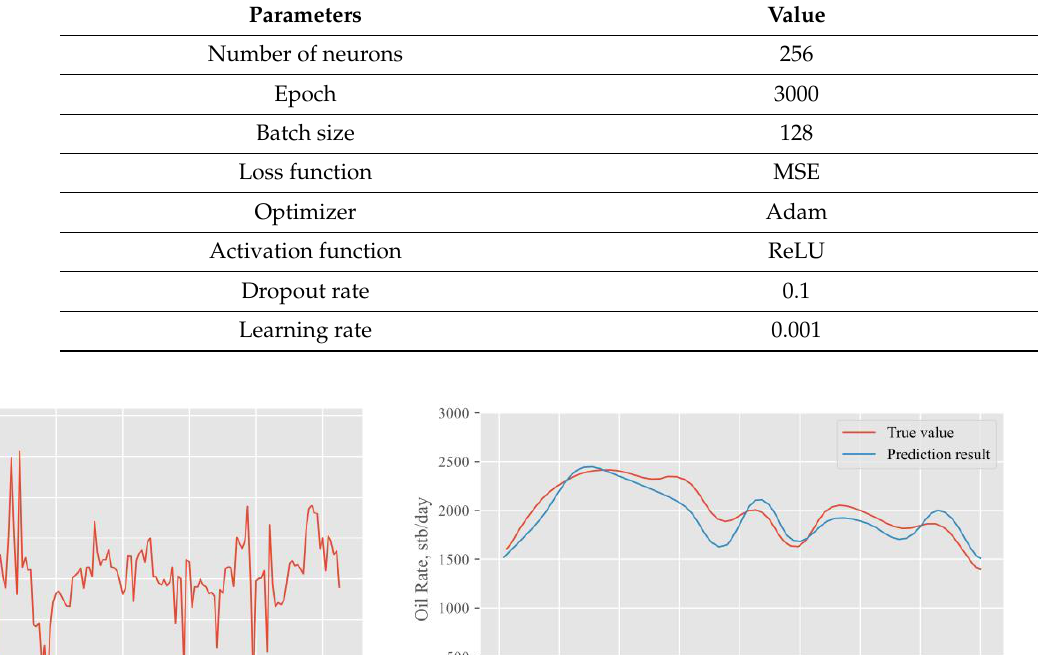
Table 2. The architecture of the GRU model proposed in this paper.